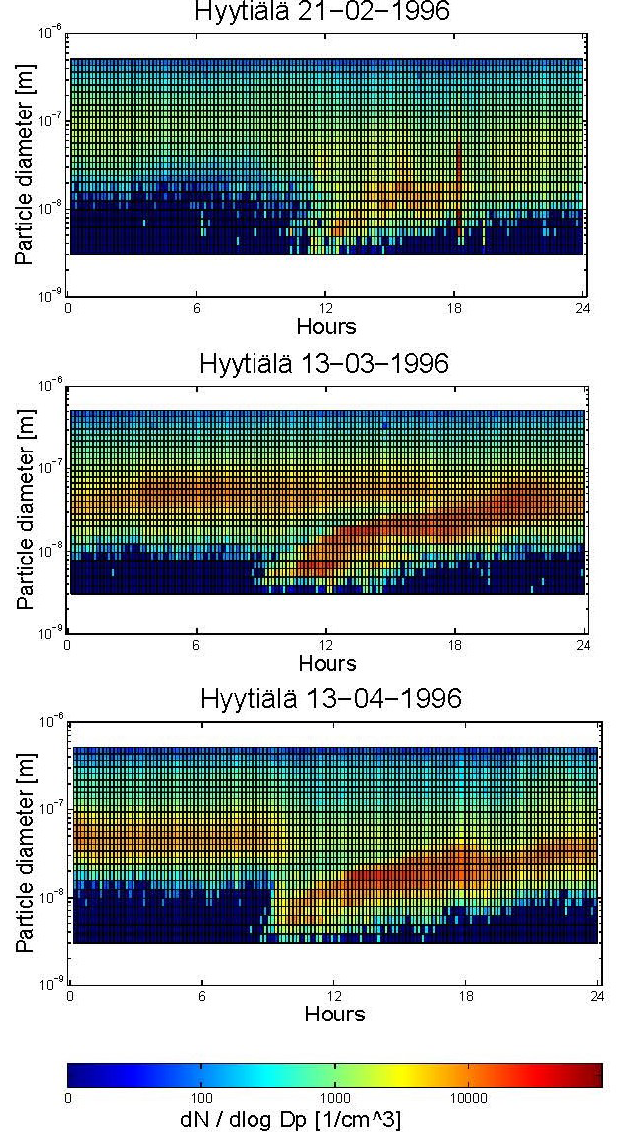
Figure 4. Contour plots of a particle formation event occurring in the morning, followed by a subsequent growing process of the nucleation mode during the afternoon. (a) 21 February 1996, (b) 13 March 1996 and (c) 13 April 1996 (Mäkelä et al., 1997). Thought to be the origin of the “banana plot” (provided from origi- nal data by Markku Kulmalu).